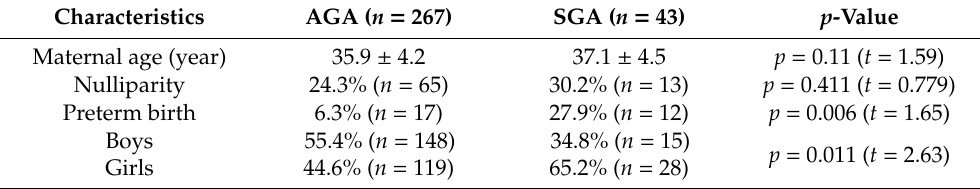
Table 1. Obstetrical characteristics of pregnant women included in the study.